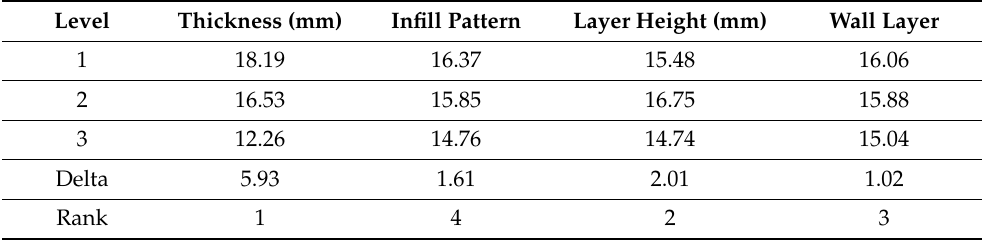
Table 4. Response of variable parameters for